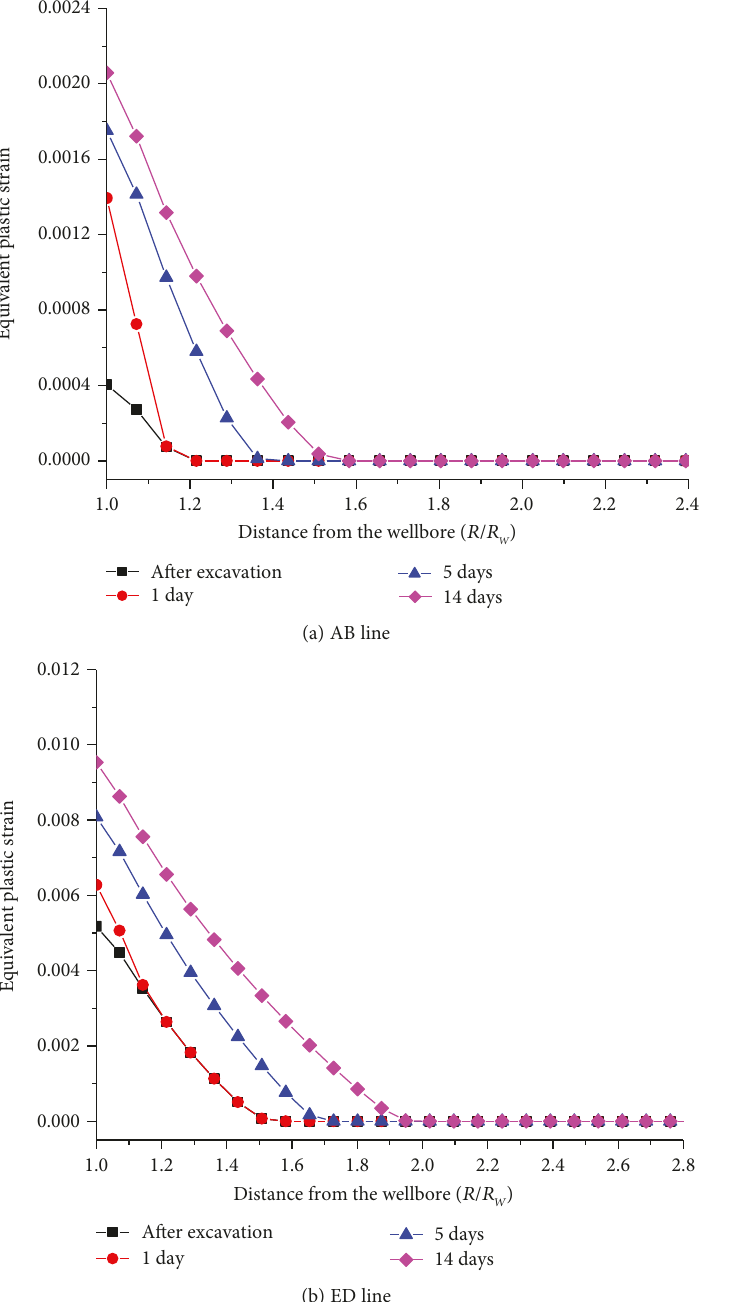
Figure 15: Equivalent plastic strain along selected lines with a drilling fl uid density of